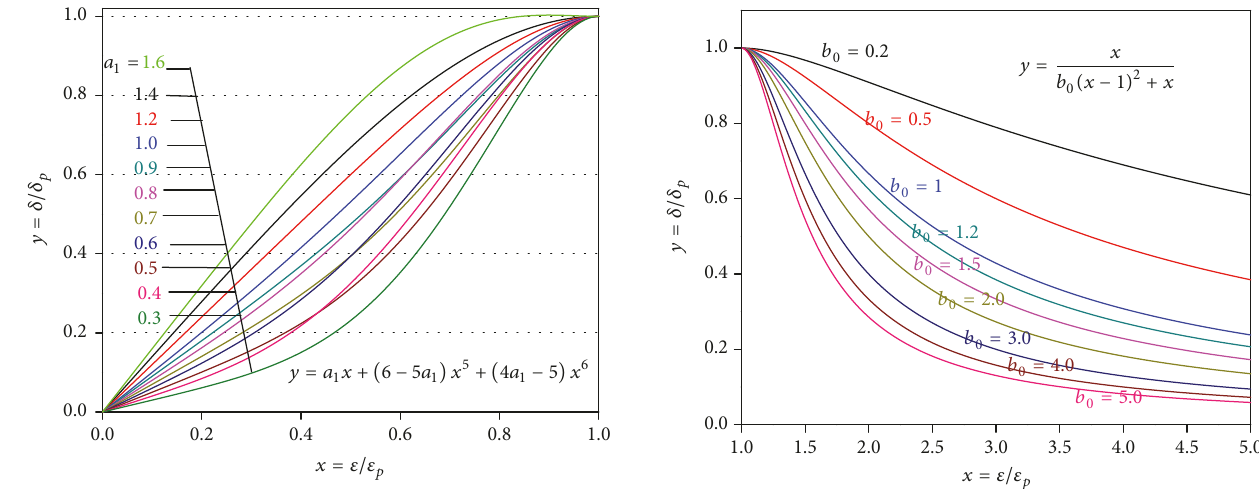
Figure 10: 𝑎 1 and the calculated curve at the ascent stage.